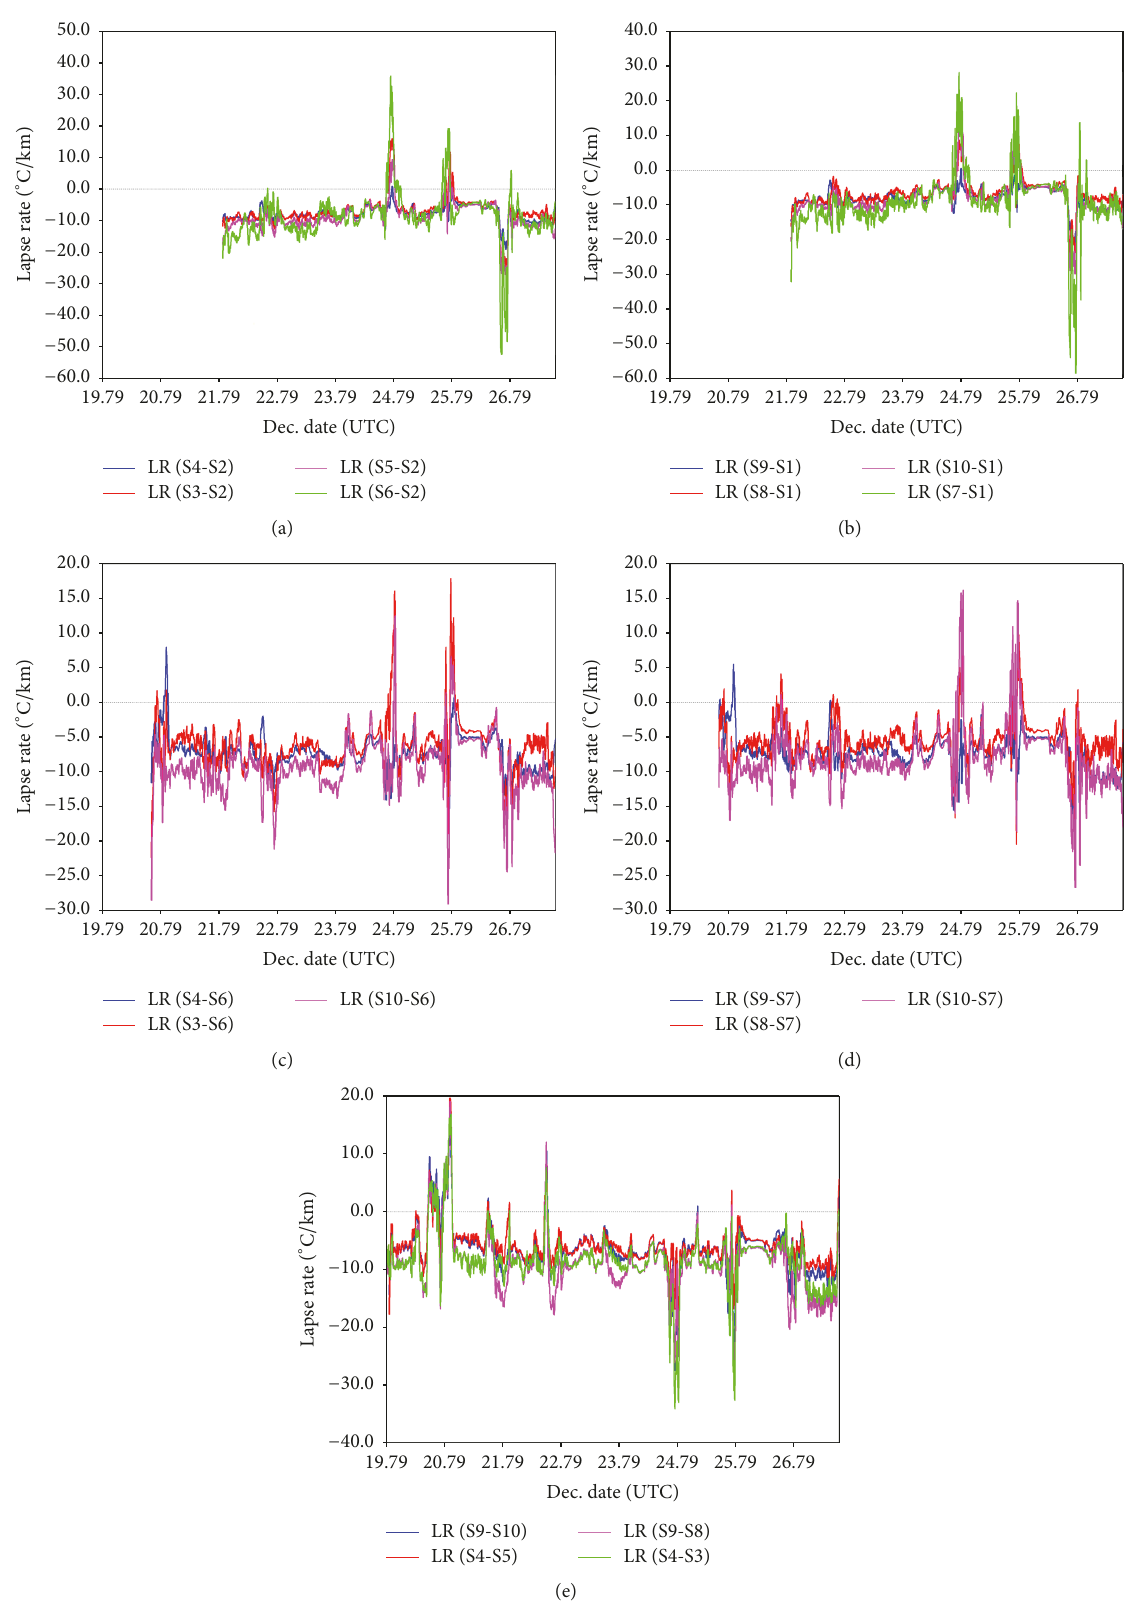
Figure 7: Near-surface glacier lapse rate variations over time, at 2-m height above the glacier surface, based on 1-min Tinytag temperature data. Different base stations (Figure 1) are used as follows: (a) S2/Station 5 (near the bottom of the glacier); (b) S1/Station 5; (c) S6/Station 4; (d) S7/Station 4; and (e) lapse rates are for the upper half of the glacier (base Stations 2 and